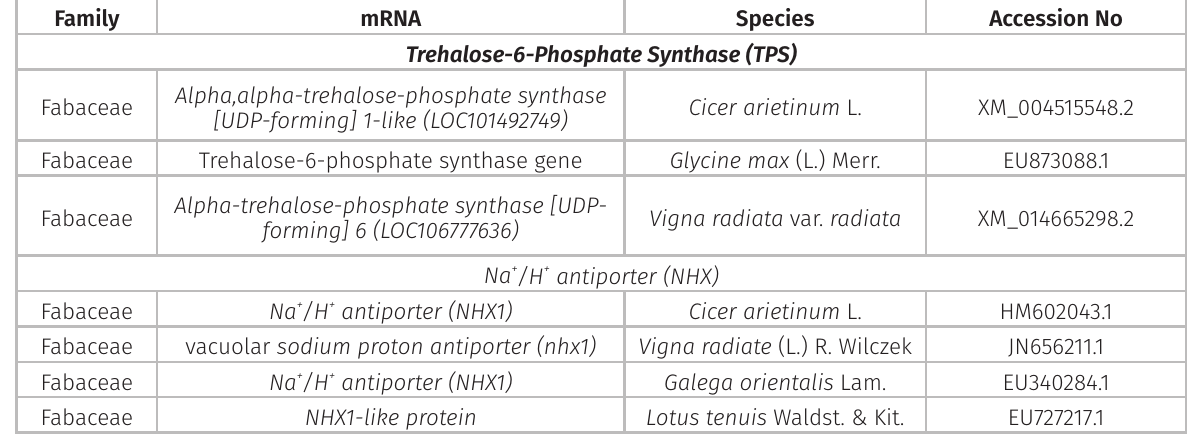
Table I. TPS and NHX gene homologs from NCBI GenBank used for V. turcica putative gene analysis and mRNA sequences